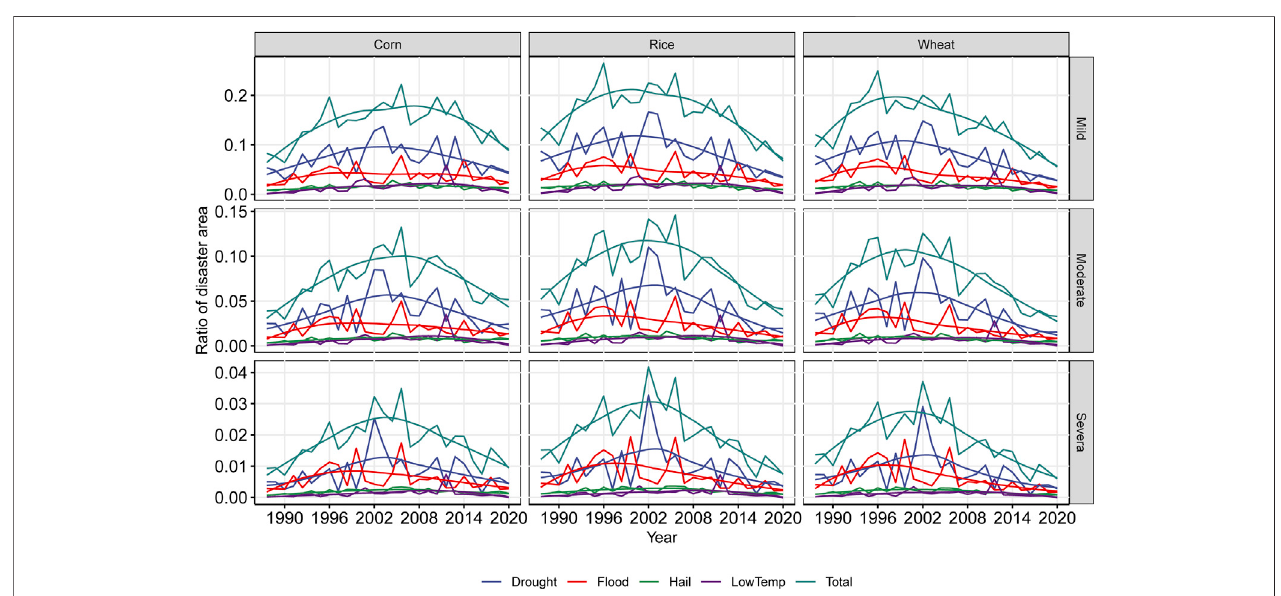
Frontiers in Environmental Science |